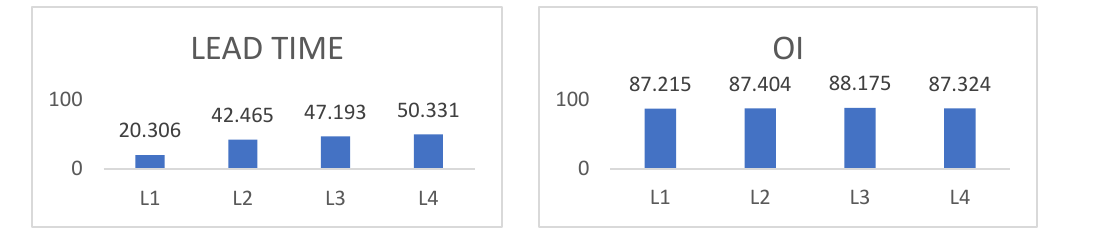
Figure 9. Operational Income compilation. Figure 8. Lead time compilation